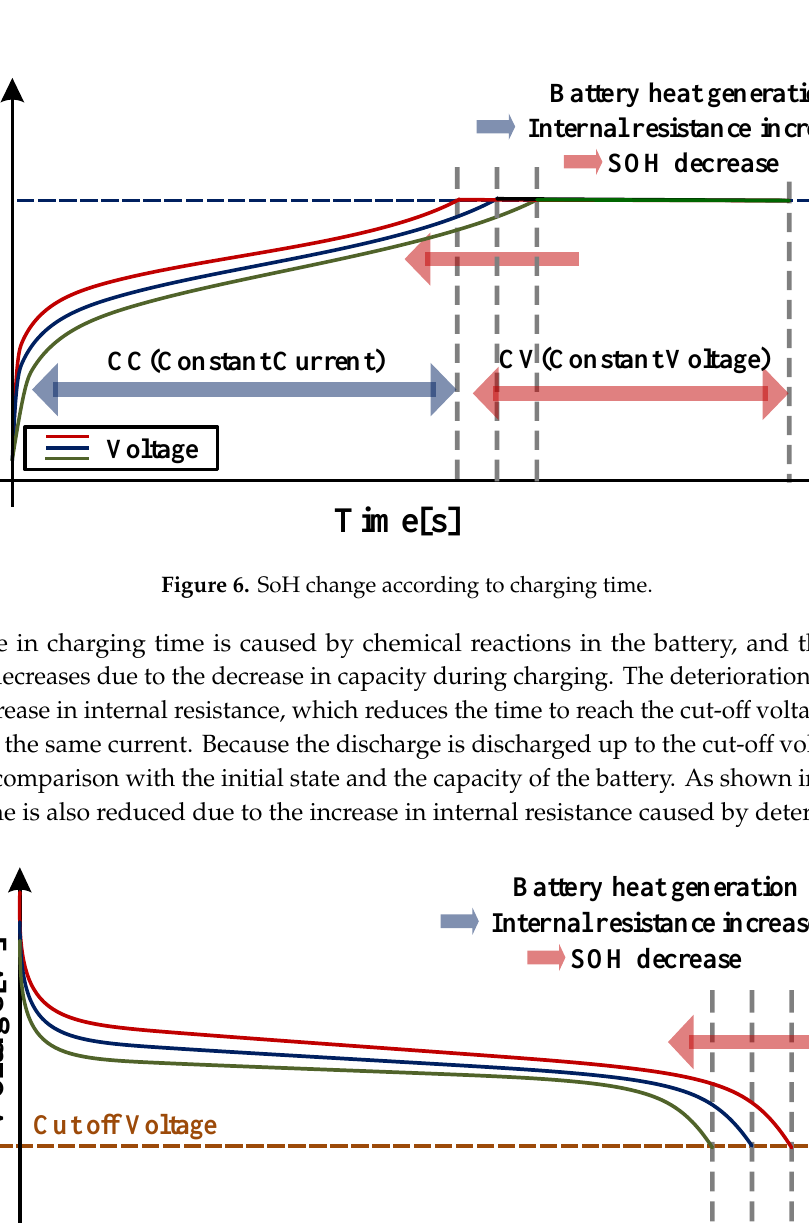
Figure 5. CC-CV charge control of battery.